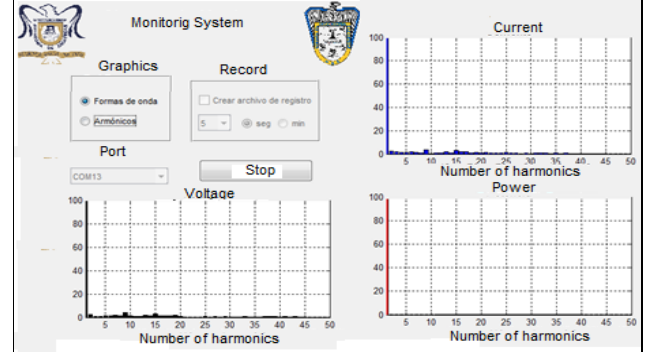
Figure 13: Harmonic components obtained through the prototype with the multilevel inverter and resistive load. Source: Authors, (2021).